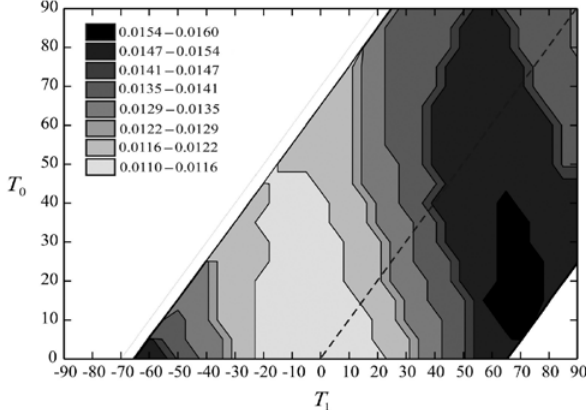
Figure 7: Contour plot of Ω for the soft simply supported E-glass/ epoxy [  〈 T / T 〉] circular laminate. 0 1 s